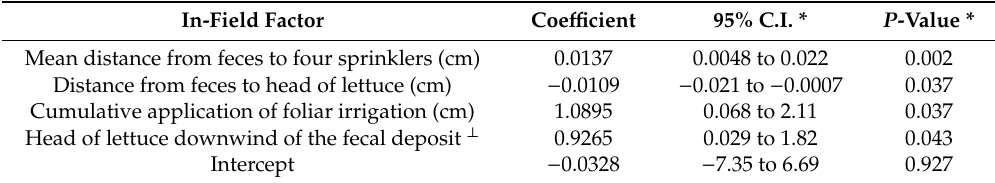
Table 2. Experiment A. Negative binomial regression model for in-field contributing factors associated with the transfer of indicator E. coli Rif r onto heads of mature Romaine lettuce (MPN / lettuce head) from animal feces placed in the furrow adjacent to beds of